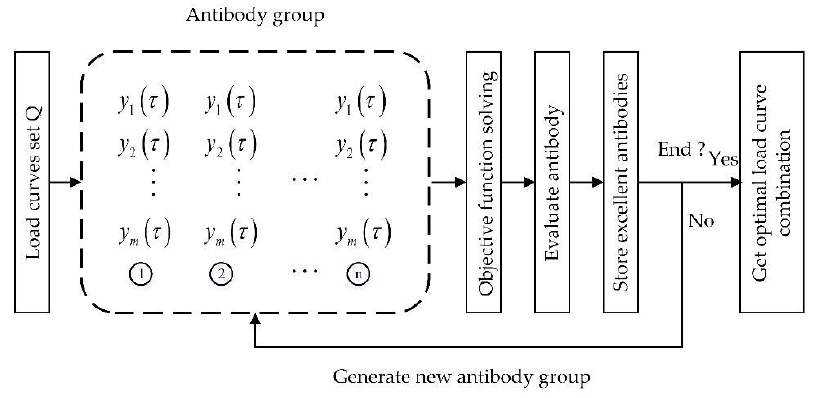
Figure 6. Optimization of objective function.